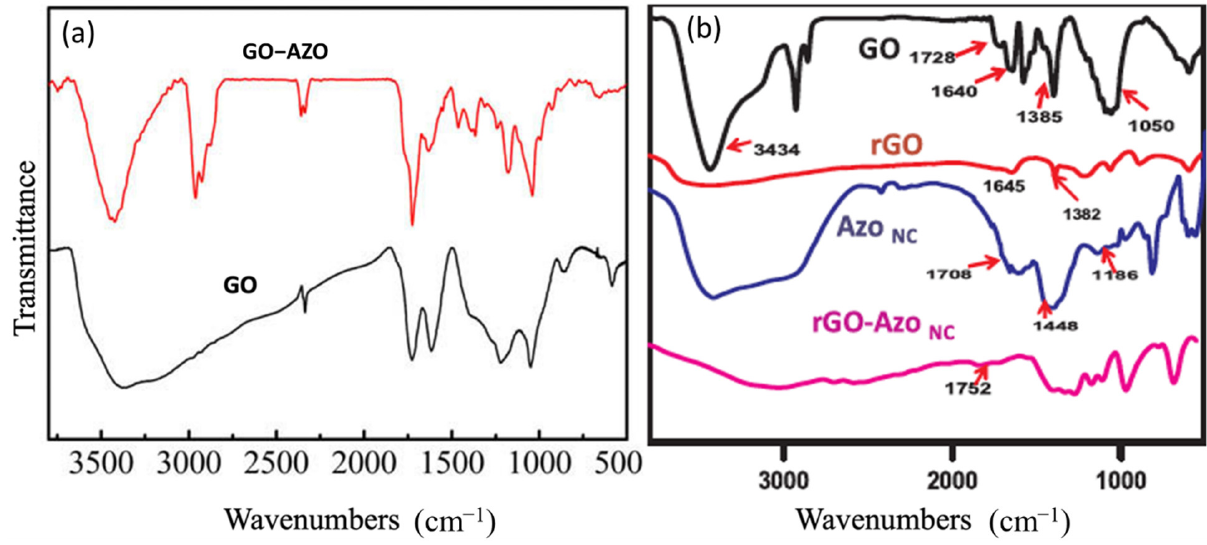
Figure 18. FTIR spectra of GO, GO-AZO, and RGO-AZO composites by ( a ) Covalent and (Reprinted from [97]; Copyright @ 2010 Elsevier) ( b ) Non-covalent functionalization. (Reprinted from [113]; Copyright @ 2019, Elsevier).